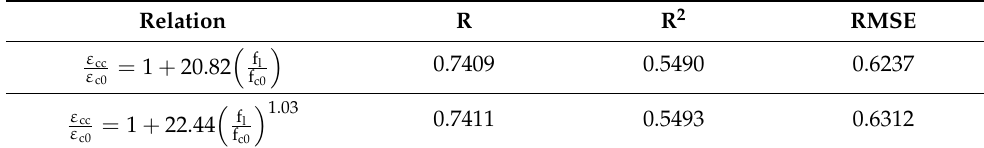
Table 6. Regression analysis results of Equations (12) and